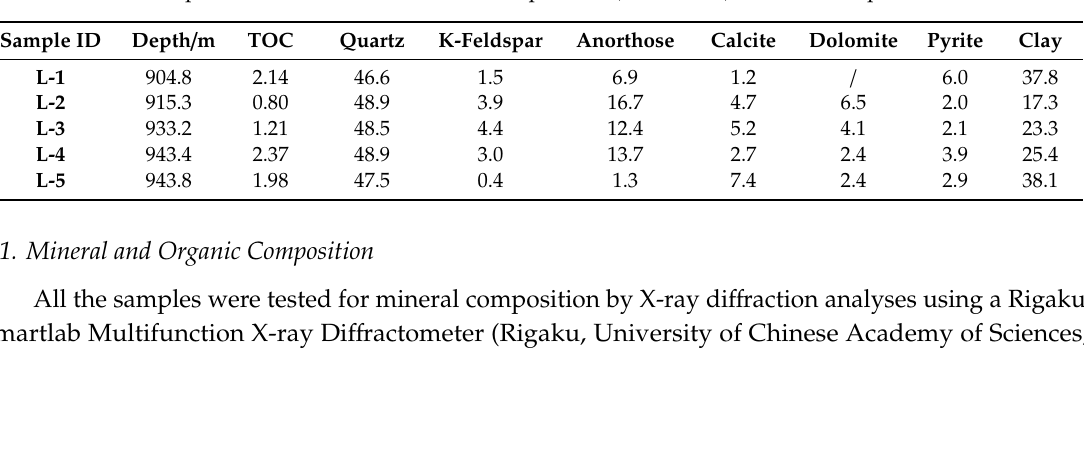
Table 1. The depth, TOC content, and mineral composition (all in wt %) of all the samples in Well